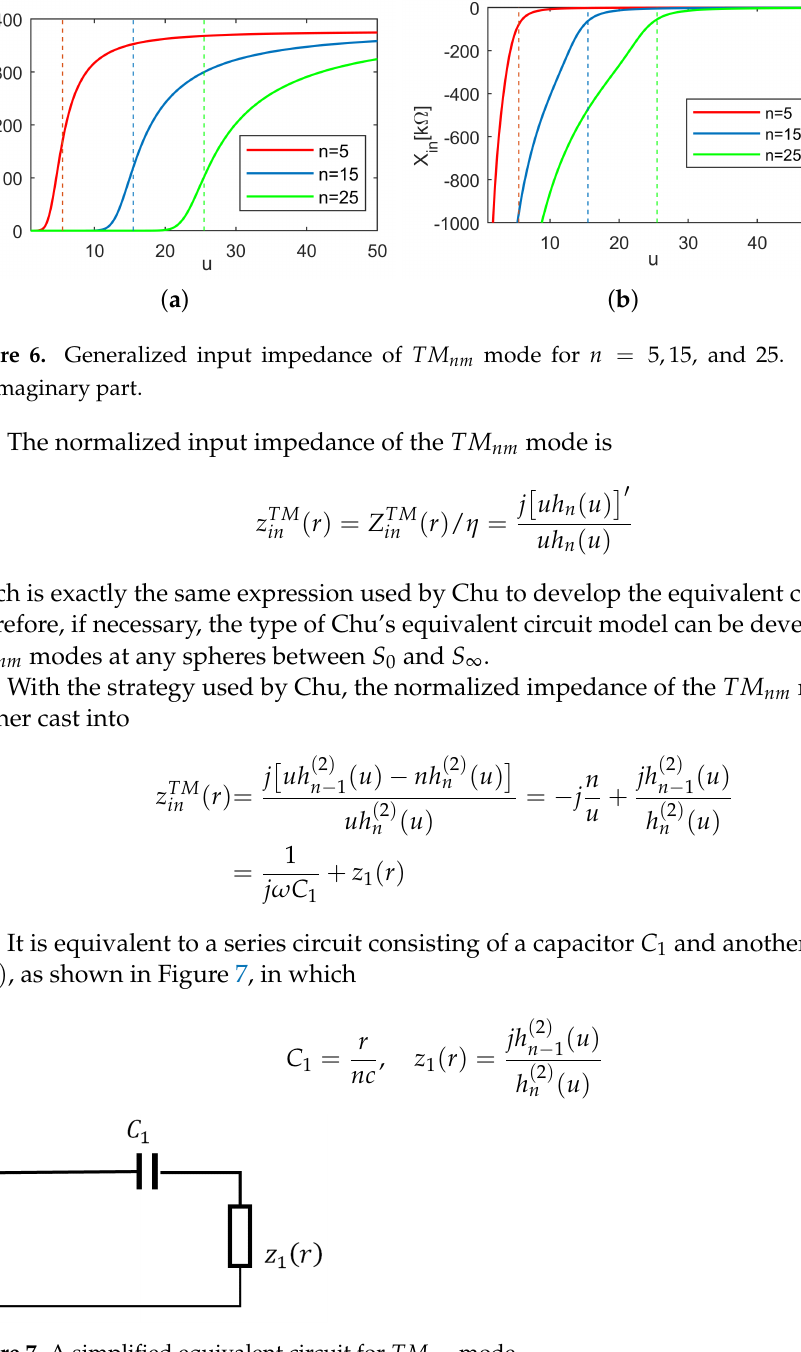
Figure 7. A simplified equivalent circuit for TM nm